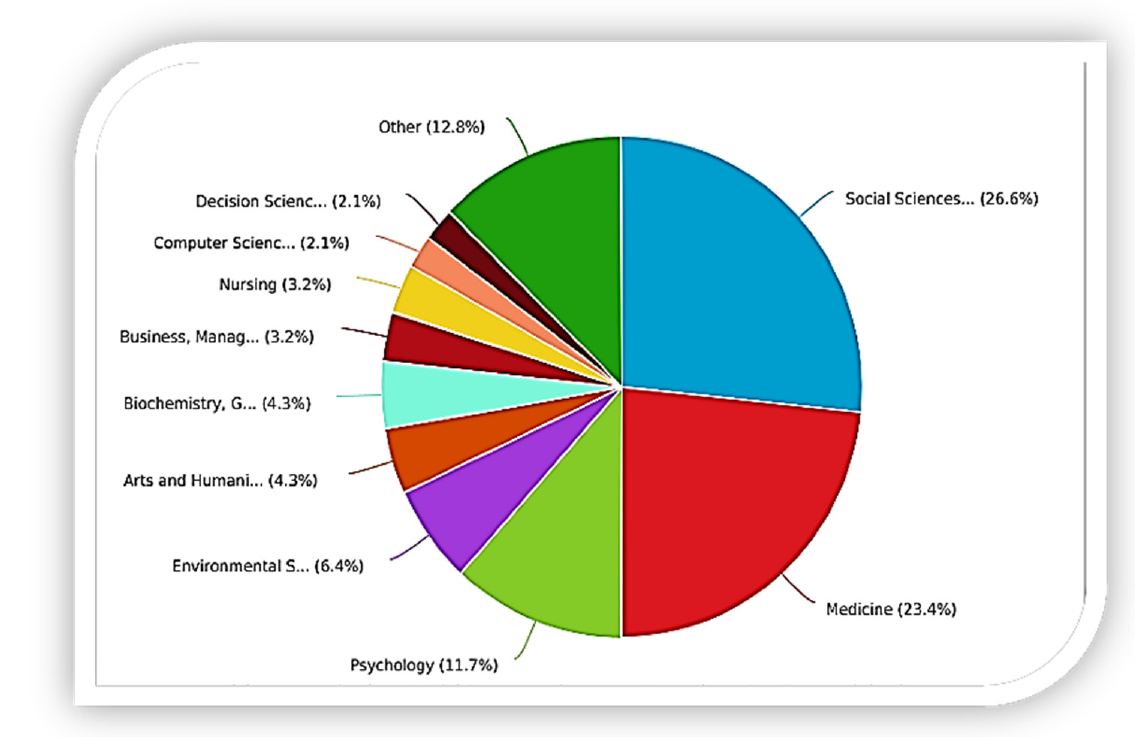
Figure 6. Distribution by Discipline Area.